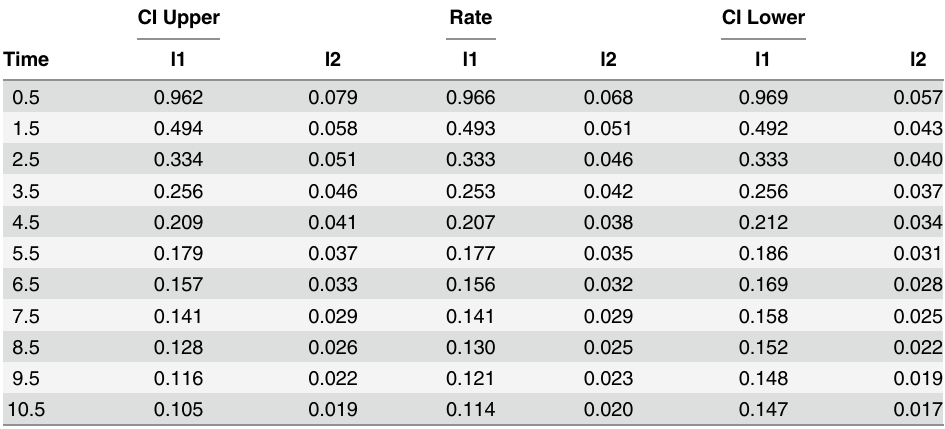
Table 2. Rate of reinfection disease, with confidence intervals for various times after